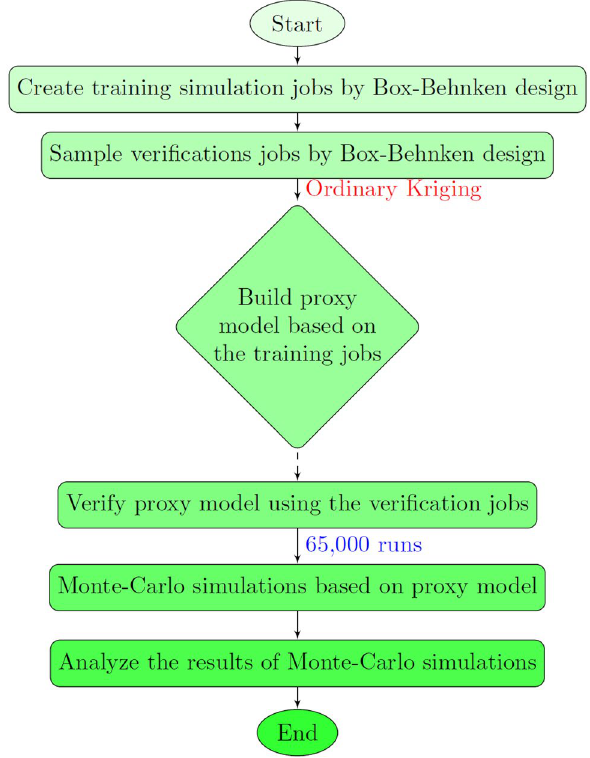
Fig. 10 Flowchart of production uncertainty assessment of the cyclic GAGD